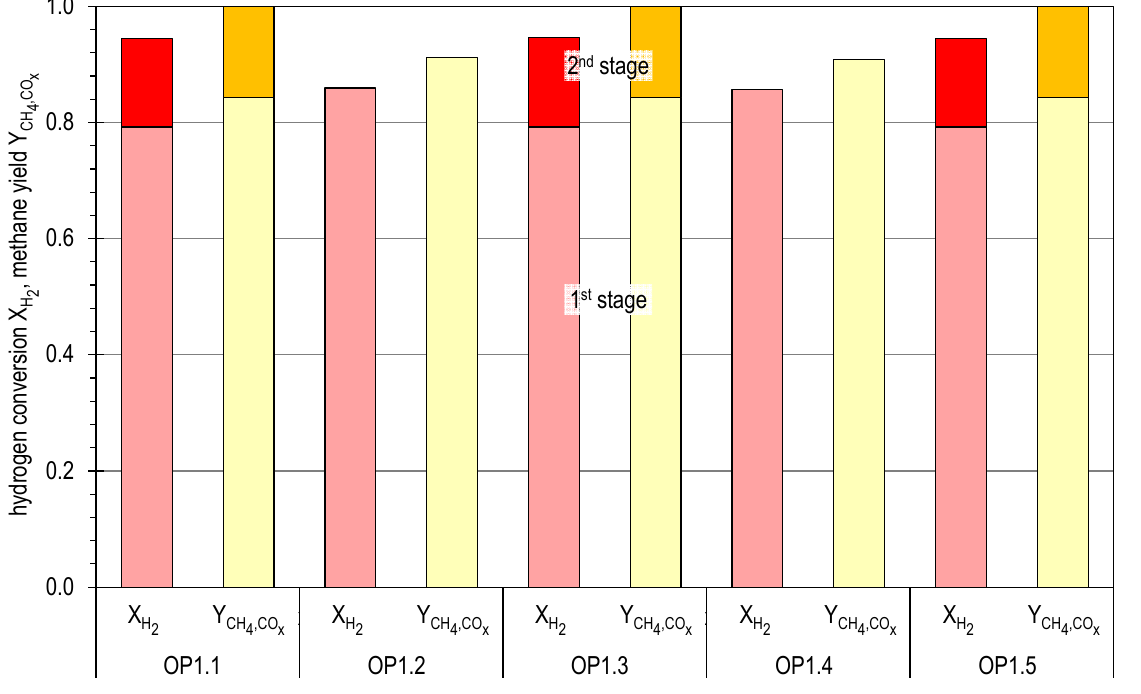
Figure 17. SC1. Hydrogen conversion, X H2 , and methane yield, Y CH4,COx , after first and part of second methanation stage for the different operating points of FAU_CH4_TR.